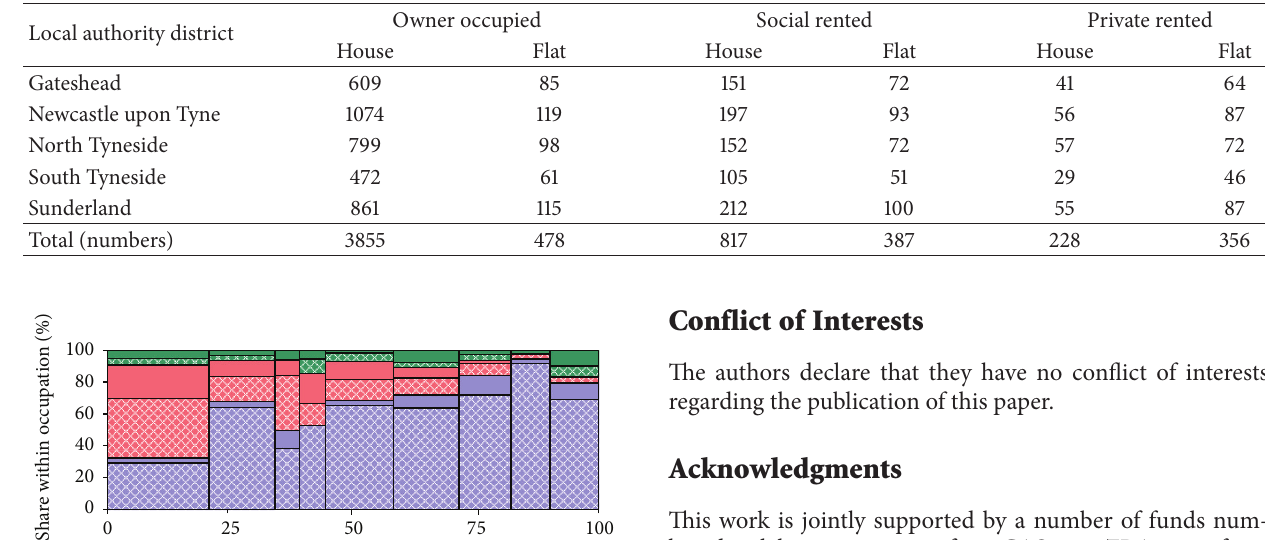
Table 2: Net additional housing demand by local authority district, 2008–2016.